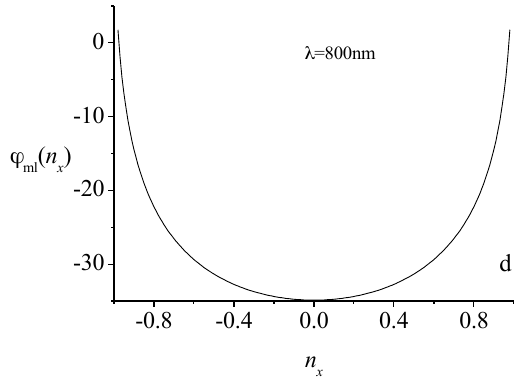
Fig. 4 Phase functions - ( ,20,15) (dash) ( а ) and total phase function ( )